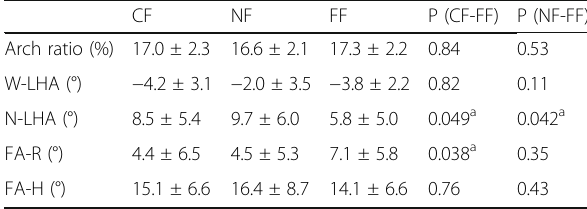
Table 2 Alignment data among the groups